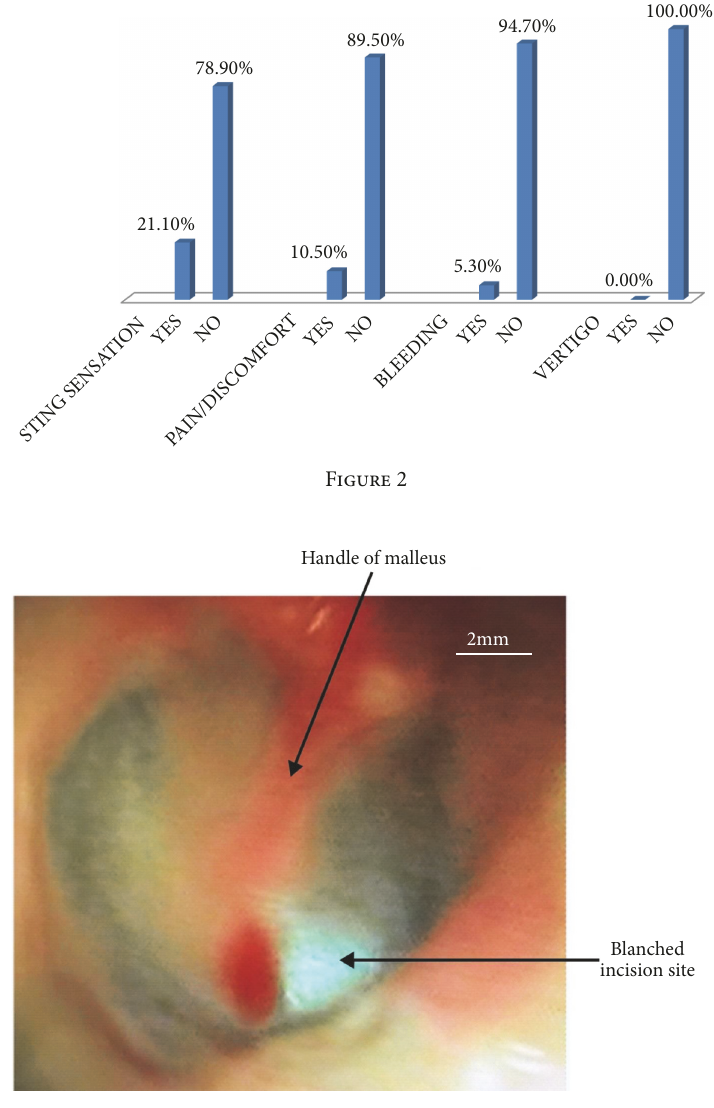
Figure 3: Shows blanching effect of the tympanic membrane by